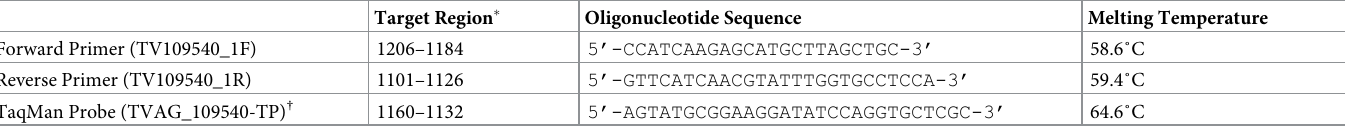
Table 1. Primer and TaqMan probe sequences for the T . vaginalis